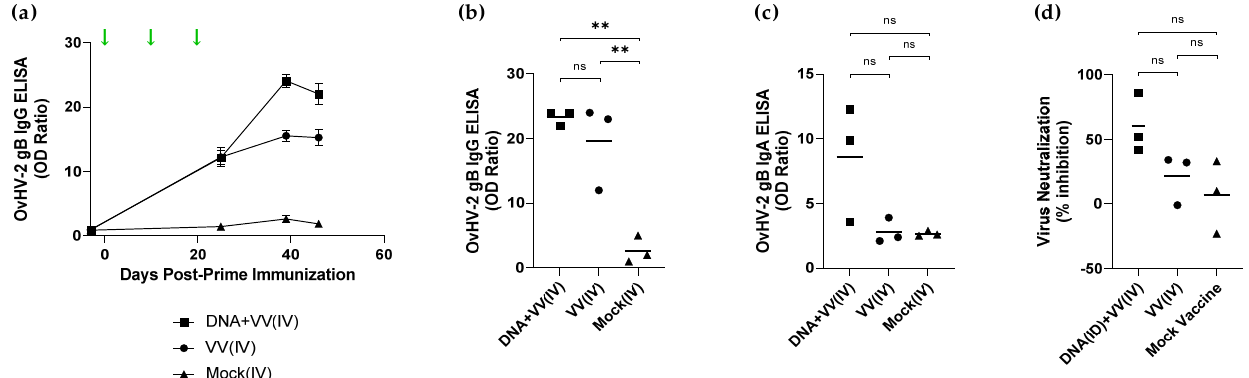
Figure 2. Anti-OvHV-2 gB antibody responses in three animals immunized with OvHV-2 DNA plus AlHV-1-vectored vaccine [DNA+VV(IV)], AlHV-1-vectored vaccine only [VV(IV)], or mock control [Mock(IV)] and euthanized prior to challenge in experiment 1. Anti-OvHV-2 gB antibodies of both isotypes were detected by ELISA assays. ( a ) IgG kinetics in plasma. Green arrows represent immunizations and error bars are SEM; ( b ) IgG in bronchial alveolar lavage (BAL) fluid; ( c ) IgA in BAL fluid, and ( d ) neutralizing antibody response in BAL fluid. BAL fluid was collected at 46 days post-prime immunization. Bars in panels ( b – d ) indicate mean; ns, no statistically significant difference between groups; **, p < 0.01.